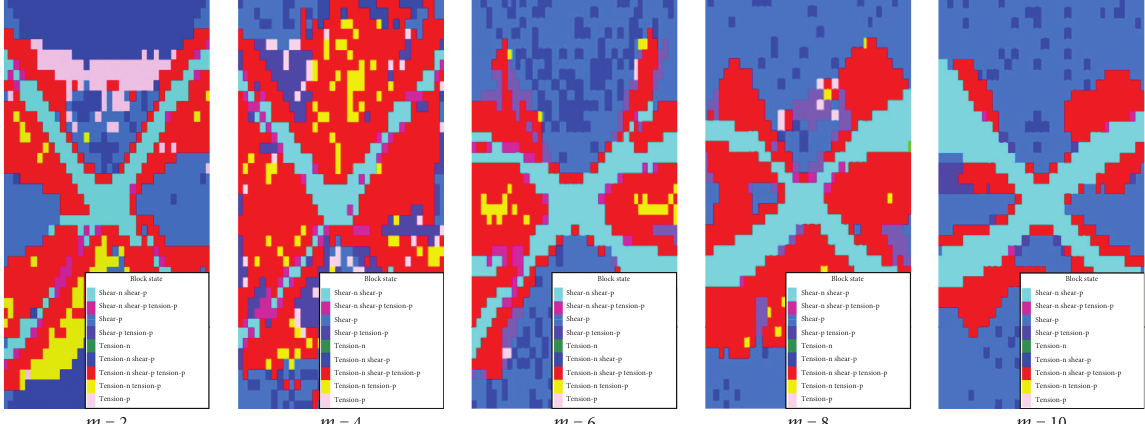
Figure 16: Plastic strain contour of No. 12 coal specimen under random assignment of cohesion by Weibull